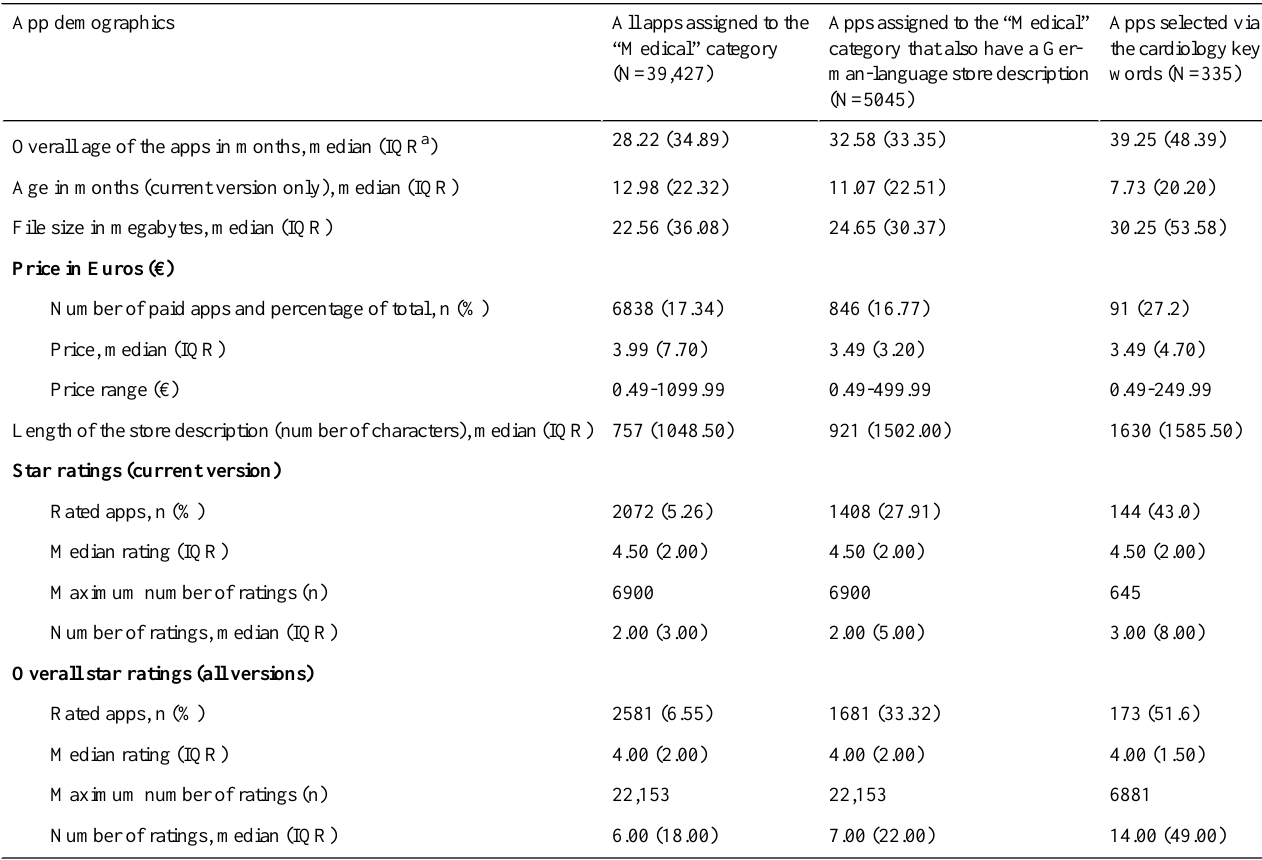
Table 5. App demography in comparison: apps within the “Medical” category versus those for which a German-language store description was provided versus those having a cardiology